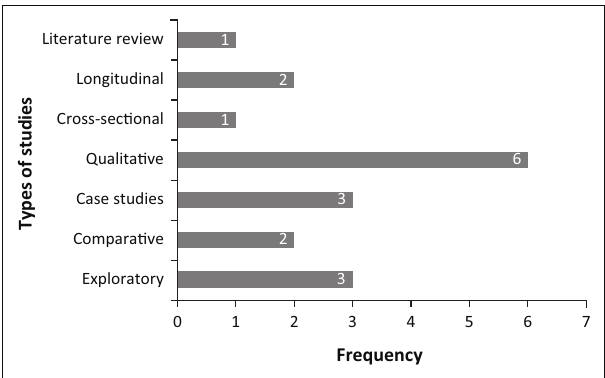
FIGURE 3: Bar graph representing the types of studies included in the scoping